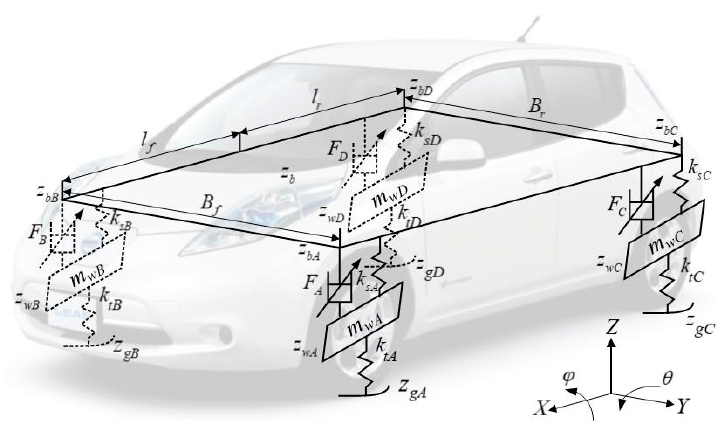
Figure 2. Full vehicle model of regenerative suspension.